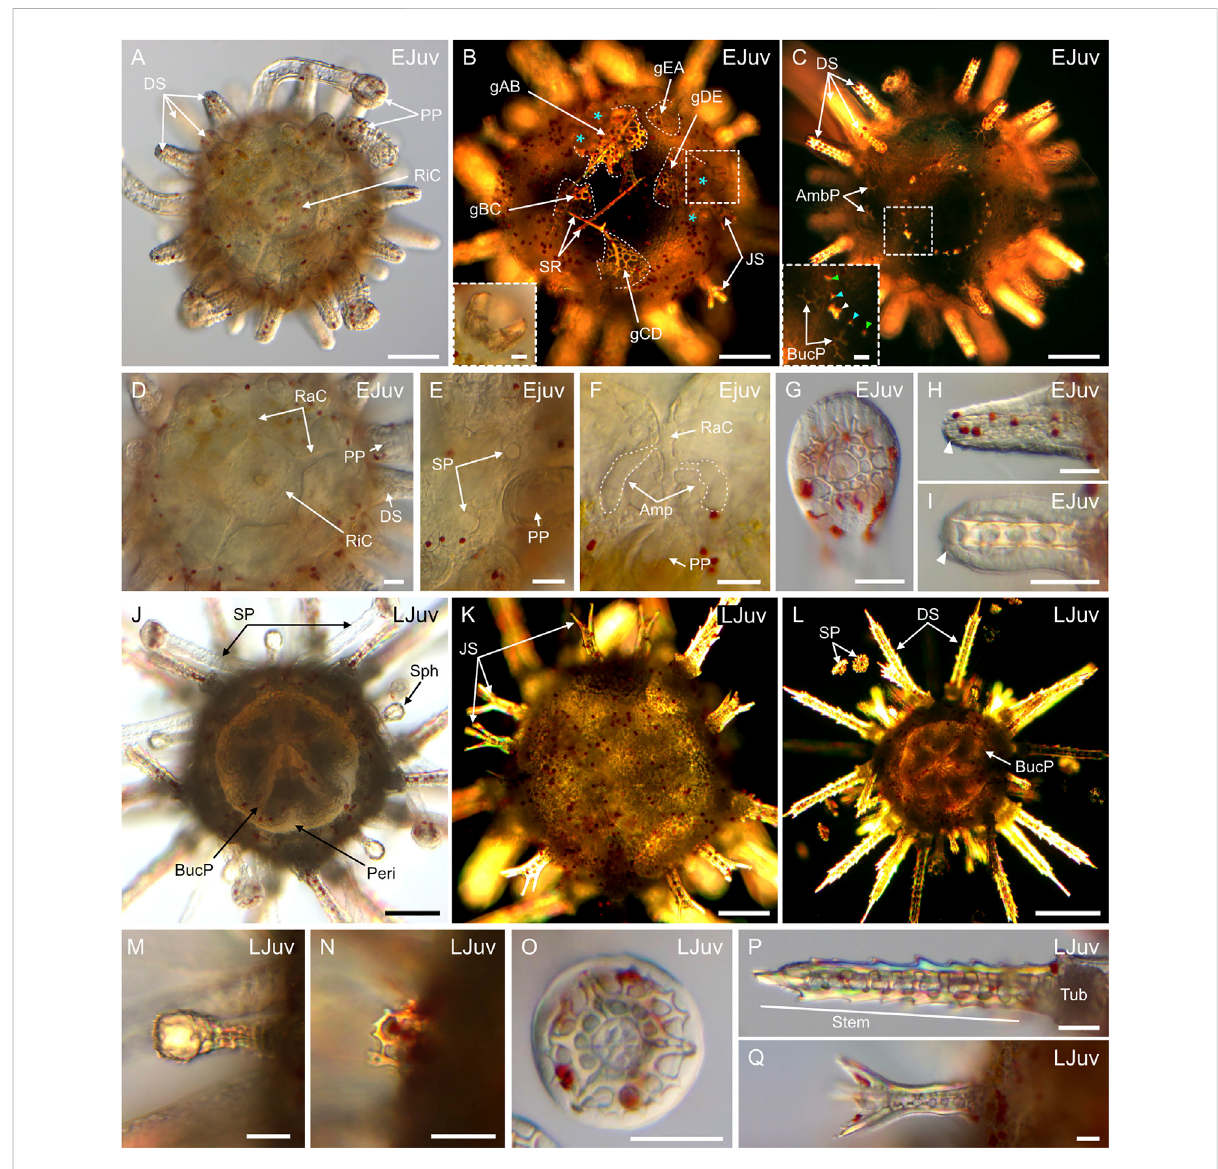
FIGURE 16 Anatomy of early and late juveniles of Paracentrotus lividus . Developmental stages are as follows: (A – I) early juvenile stage, 1 day post- metamorphosis (EJuv); (J – Q) late juvenile stage, 8 days post-metamorphosis (LJuv). In (A,D – J,M – Q) , images were acquired using bright- fi eld light microscopy. In (B,C,K,L) , images were obtained using polarized light microscopy. In (A – D,J – L) , images correspond to specimens in oral view in (A,C,D,J,L) and in aboral view in (B,K) . ( (B) inset) Close-up of an opened pedicellaria. ( (C) inset) Close-up of the skeletal elements constituting the primordia of the adult masticatory apparatus. (D) Close-up of the ring and radial canals of the water vascular system. (E) Close-up of a pair of growing secondary podia located underneath aprimary podium. (F) Close-up of theampullae formed attheproximaltip of aradial canal. (G) Close- upoftheskeletaldiskwithinthepapillaofaprimarypodium. (H) Close-upofadevelopingde fi nitivespine. (I) Close-upofadevelopingjuvenilespine. (M) Close-up of a sphaeridium. (N) Close-up of a degenerated primary podium. (O) Close-up of the skeletal disk within the papilla of a secondary podium. (P) Close-up of a fully formed de fi nitive spine. (Q) Close-up of a fully formed juvenile spine. In (B) , cyan asterisks mark the pedicellariae present on the aboral surface of the juvenile, and white dotted lines delineate the genital plates. In ( (C) inset), the white arrowhead indicates a tooth primordium, cyan arrowheads highlight primordia of the hemipyramids, and green arrowheads mark primordia of the epiphyses. In (F) , white dotted lines outline two ampullae formedat theproximal tip ofaradial canal. In (H,I) ,white arrowheads indicate theapex ofa growing de fi nitivespine in (H) and of a growing juvenile spine in (I) . Scale bar: (A – C,J – L) 100 μ m; ( (B) inset, (C) inset, (D – I,M – Q) ) 30 µm. Amp: ampulla; AmbP: ambulacral plate; BucP: buccal plate; DS: de fi nitive spine; gAB: genital plate AB; gBC: genital plate BC; gCD: genital plate CD; gDE: genital plate DE; gEA: genital plate EA; JS: juvenile spine; Peri: peristome; PP: primary podium; RaC: radial canal; RiC: ring canal; SP: secondary podium; Sph: sphaeridium; SR: skeletal rod; Tub: